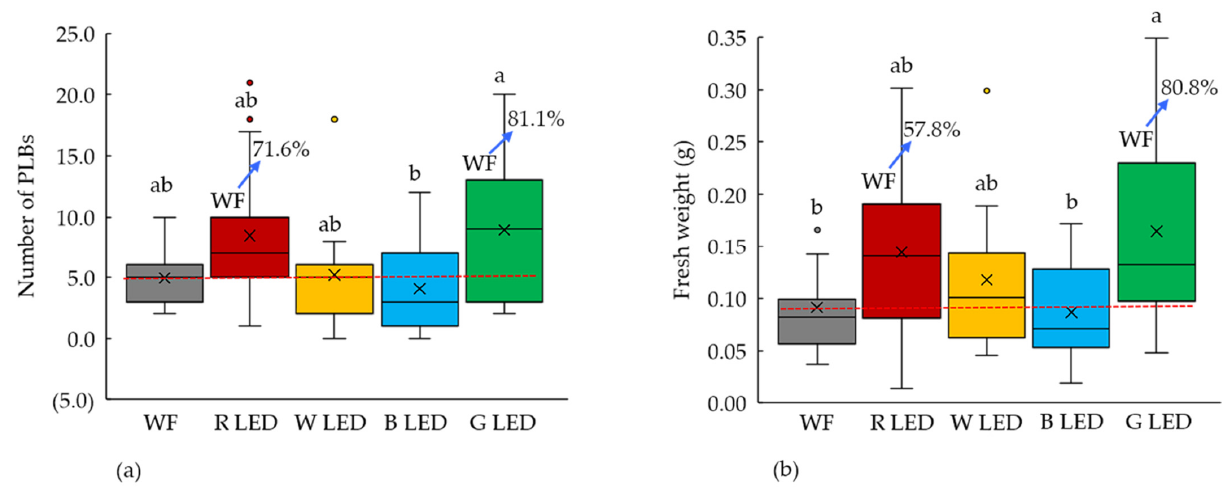
Figure 1. In vitro PLB regeneration of D. okinawense under different LEDs on ( a ) the number of PLBs and ( b ) fresh weight. WF; White fluorescent light, R; red, W; White, B; Blue, and G; Green. Crosses in the box represent the mean number of PLBs and fresh weight (total explants, n = 15). Red horizontal lines represent the mean mean value of control under white fluorescent light (WF). Blue arrows over the boxplot represent the percentage of increase from red horizontal line. Boxplots that share a letter are statistically identical in Tukey’s multiple comparison test ( p < 0.05). Table 1. PLBs proliferation percentage (%), shoot formation in percentage (%), and number of shoots regenerated from different culture conditions and media manipulation.